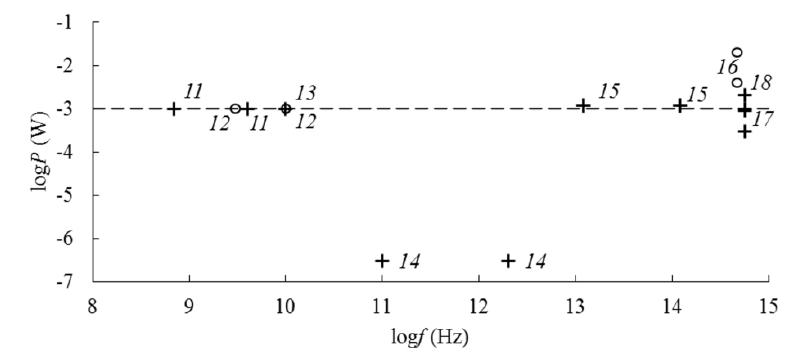
Figure 3. Frequency dependence of electromagnetic field power when interacting with nanocomposites based on the Fe m O n –SiO 2 system in the frequency range 10 8 –10 15 Hz: 11 —natural ferrimagnetic resonance (solid), 12 —magnetic permeability dispersion (liquid), 13 — electron paramagnetic resonance (solid), 14 —dispersion of the refractive index and absorption coefficient (solid), 15 —vibration absorption of Si–O–Si groups (solid), 16 — dynamic light scattering (liquid), 17 —Raman scattering (solid), 18 —phase transition magnetite → maghemite → hematite (solid). “+” corresponds to a solid state, “ ○ ” corresponds to a liquid state. The dashed line corresponds to the threshold level of change in the crystalline structure.